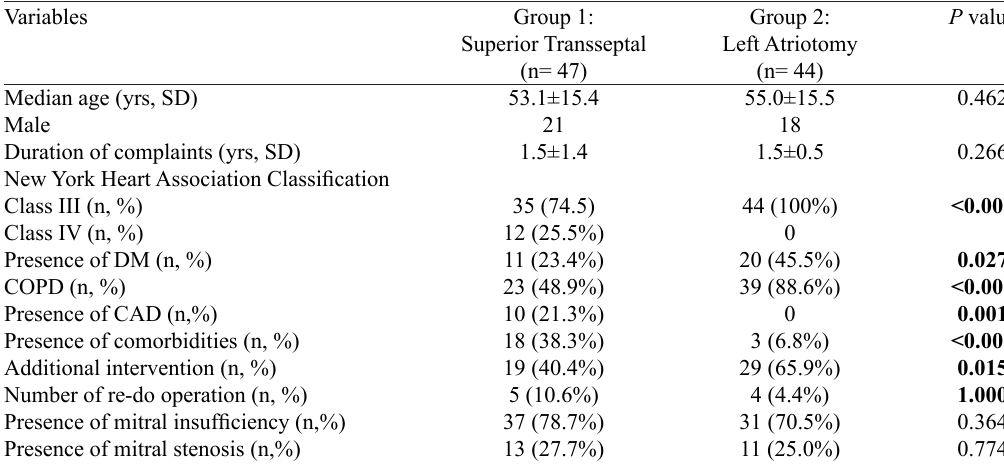
Table 1. Demographic and clinical characteristics of the